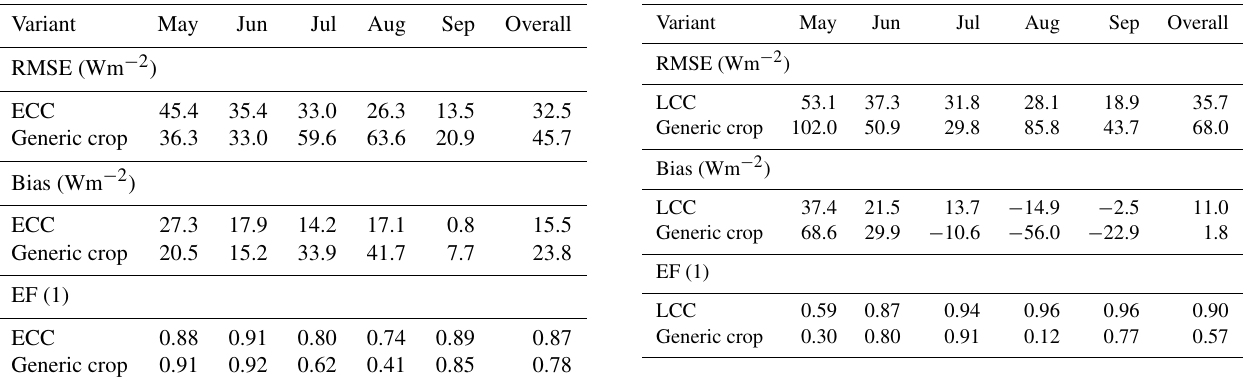
Table 5. Root-mean-square error (RMSE), bias and modeling effi- ciency (EF) of the latent heat flux for the simulation runs of winter wheat stand (EC3 field).